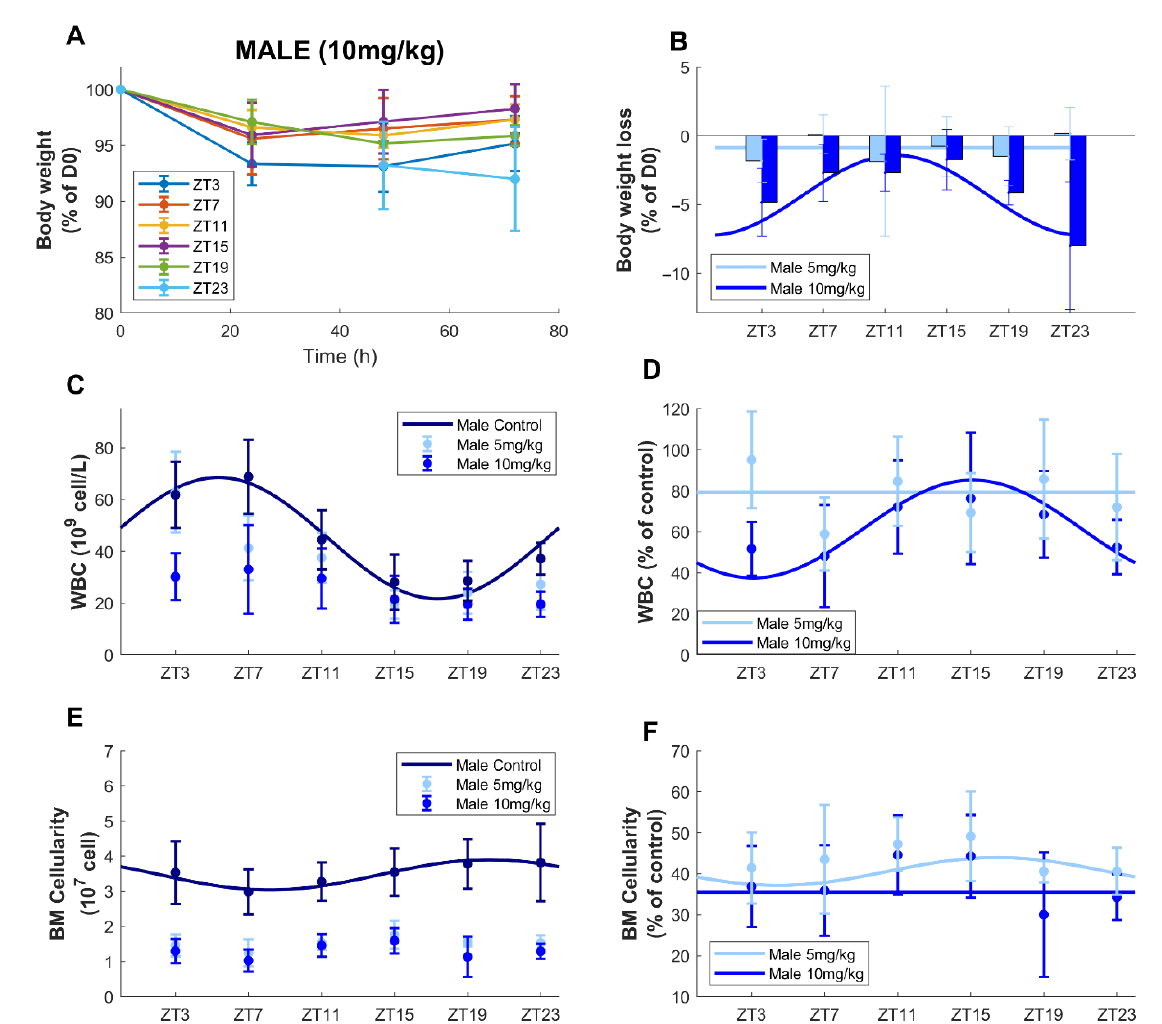
Figure 6. Timing-dependent body-weight loss (BWL), circulating blood cells, bone marrow cellularity counts after oxaliplatin single injection. ( A ) BWL over the 72 h following a single administration of oxaliplatin at indicated dose and times of administration (ZT). ( B ) Circadian rhythms of BWL 72 h after oxaliplatin injection, raw data (mean ± SD) and best fit cosinor (curves). ( C , D ) WBC and ( E , F ) bone marrow cellularity. Panels C and E show cell concentrations in control and treated datapoints (mean ± SD) conditions. Panels D and F show ratios between treated and control conditions (datapoints, mean ± SD). On all panels, solid lines are the best-fit significant cosine curves.